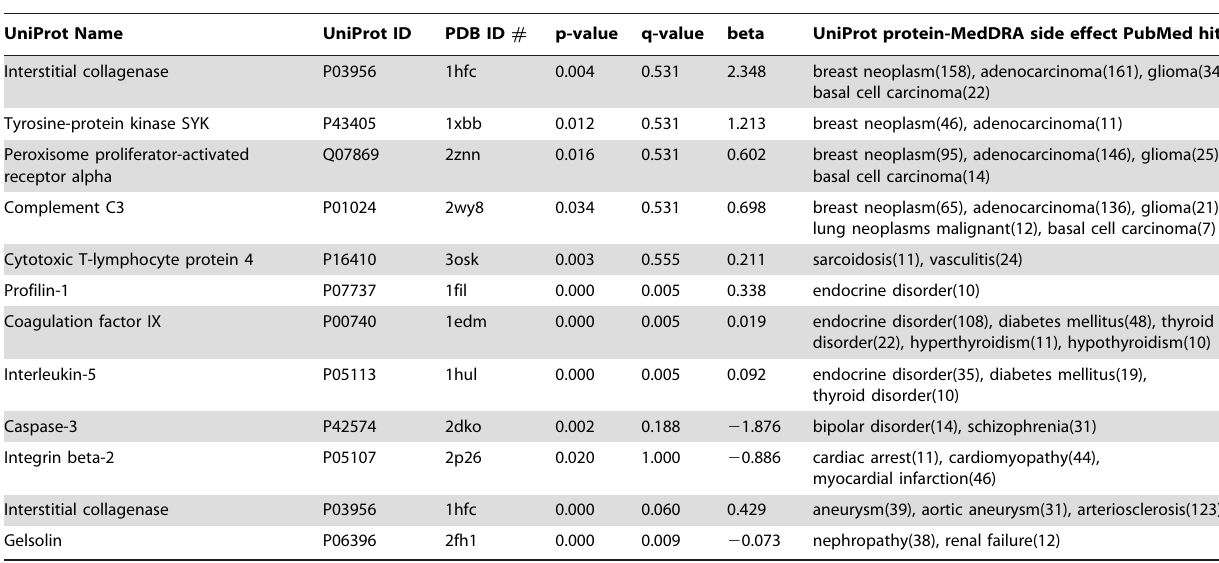
The docked protein responsible for the association with the ADR is identified in the first, second, and third columns, using the UniProt name and ID and the corresponding PDB ID, respectively. Columns 4,5, and 6 give data on the statistical significance of the association with the p-value of the association, the associated false discovery rate (q-value), and the corresponding beta coefficient in the median AUC logistic regression model. Column 7 is the PubMed results that confirm the drug- protein or drug-side effect. The number of hits is shown in parentheses. Bold UniProt IDs are off-target proteins ( i.e. not intended targets of the 732 drugs we consider).